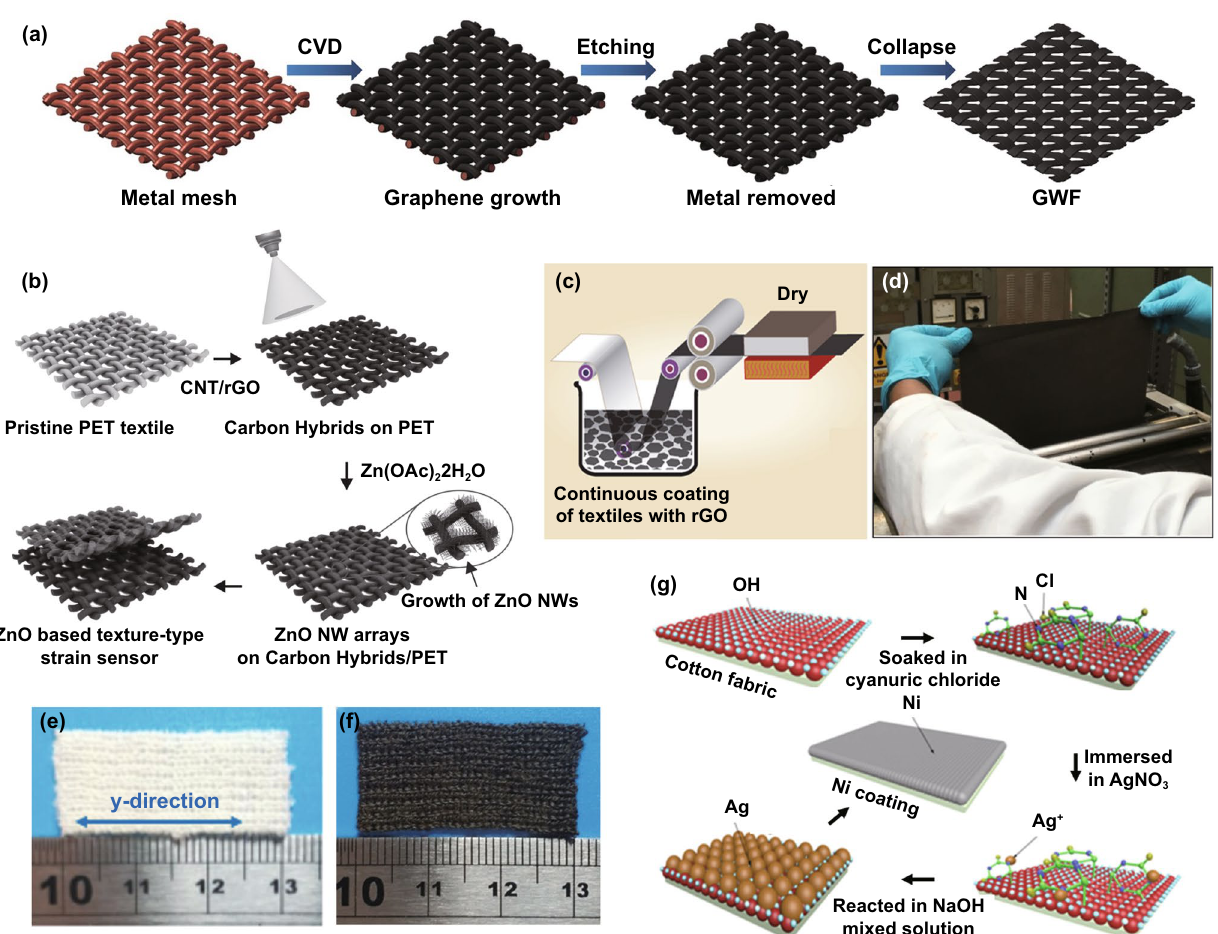
Fig. 3 a A fabric-like graphene substrate fabricated through CVD growth on a woven copper mesh, and then removing the copper [126]. Copy- right © 2012 Springer Nature. b A CNT, graphene, and ZnO NWs-coated PET fabric for the detection of bending strain [128]. Copyright © 2016 Wiley–VCH. c The process of a graphene-coated fabric by pad dying, and d the image of dyed woven fabric [129]. Copyright © 2017 American Chemical Society. e The image of a knitting wool fabric and f pad-dyed the fabric as a moisture-resilient strain sensor [133]. Copy- right © 2020 American Chemical Society. g Illustration of step-by-step Ag/Ni coating on woven cotton fabric to fabricate a strain sensor [137]. Copyright © 2018 Springer